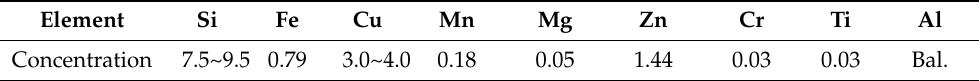
Table 1. The chemical composition of A380 aluminum alloys (mass fraction, %).